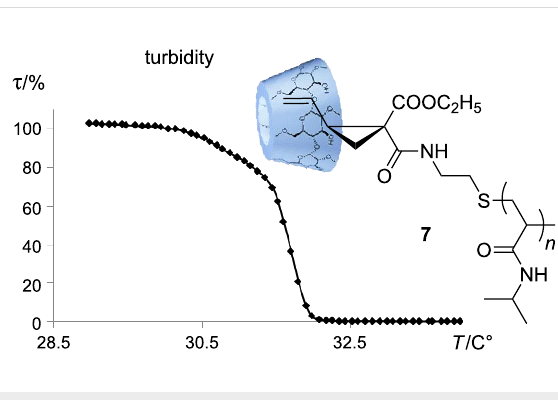
Figure 3: 2D ROESY NMR spectrum of a 5 /Me 2 - β -CD deuterated water solution.